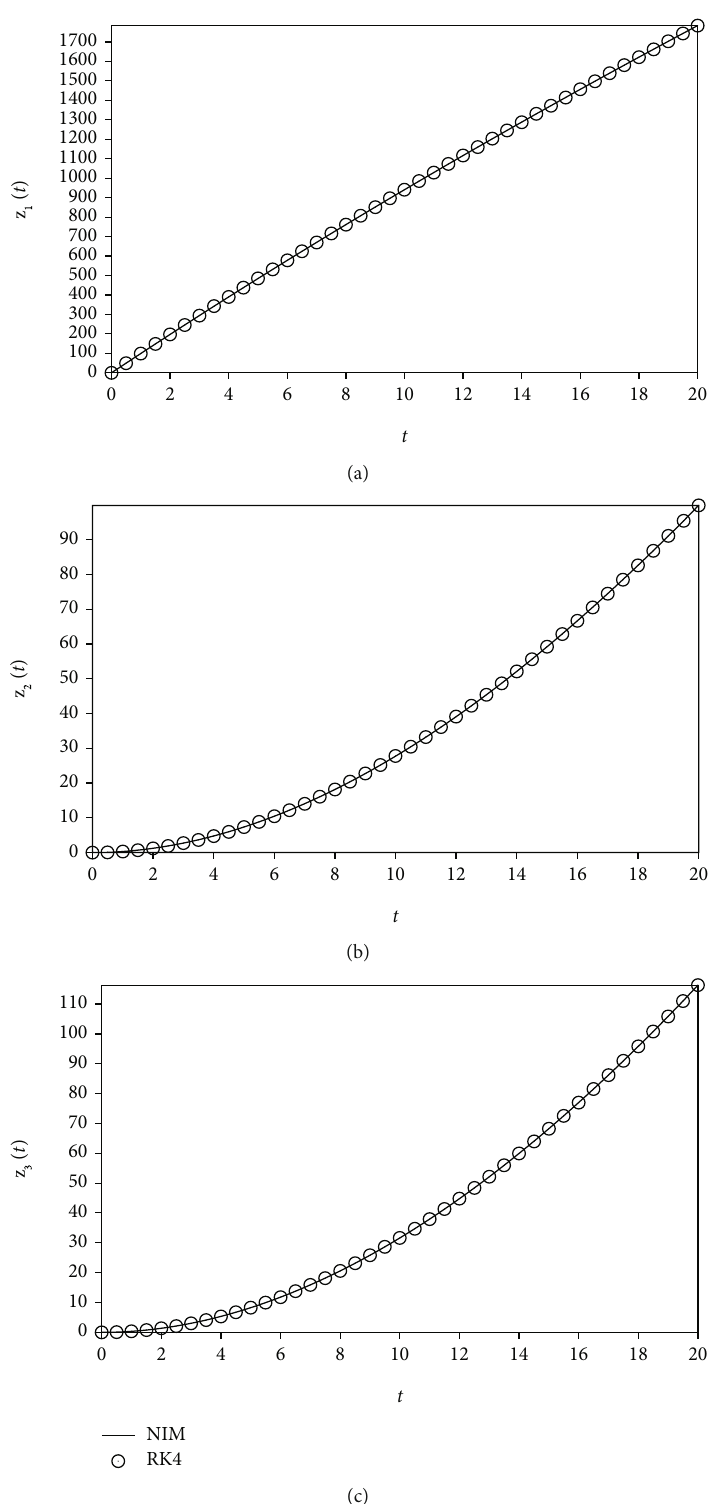
Figure 3: Comparison among NIM (solid line) and RK4 (circle) for (a) z